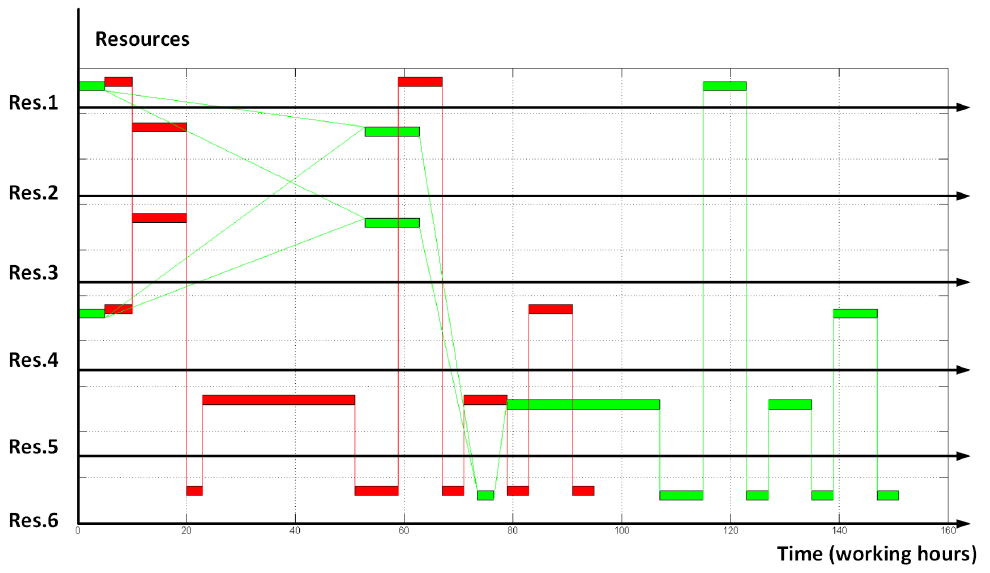
Figure 8. Gradient algorithm optimization